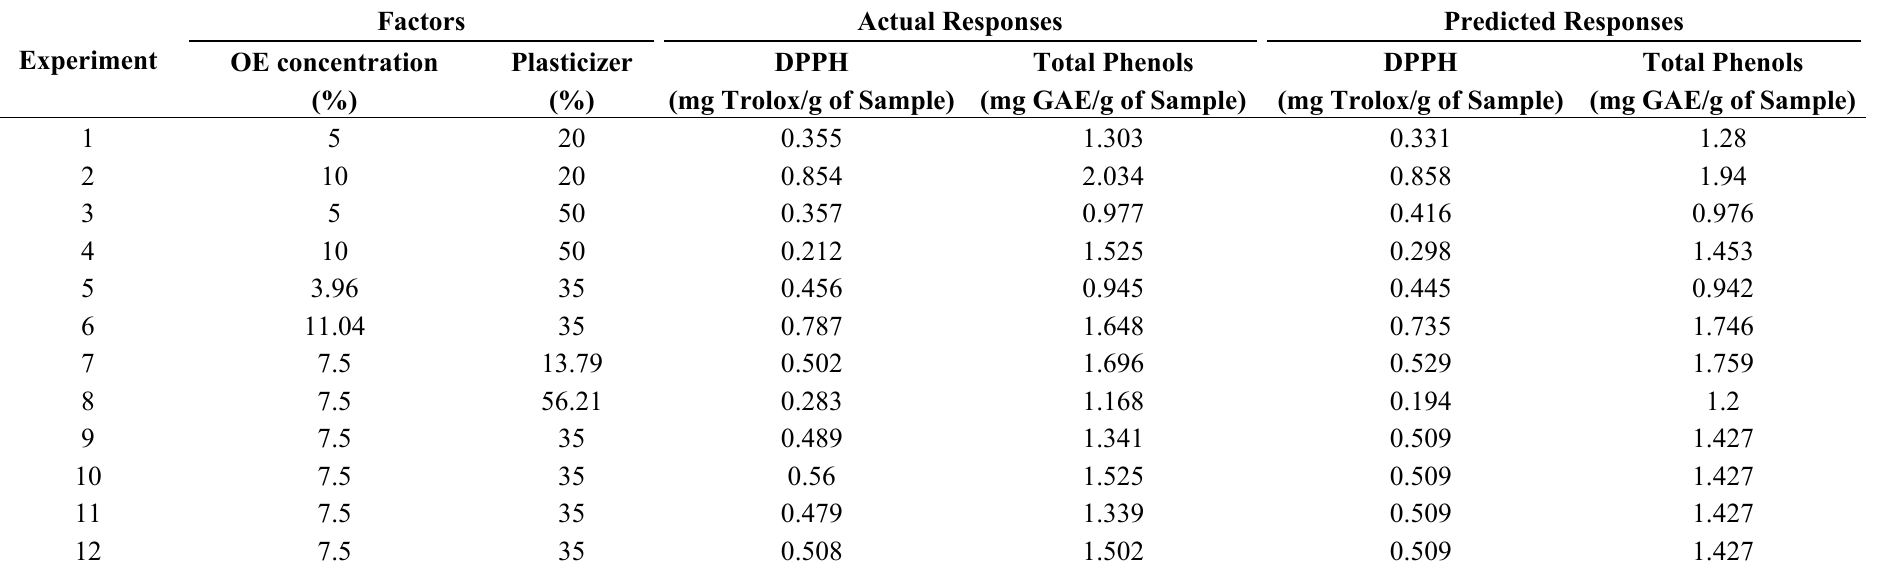
Table 2. Experimental data with coded and actual values of variables and levels.